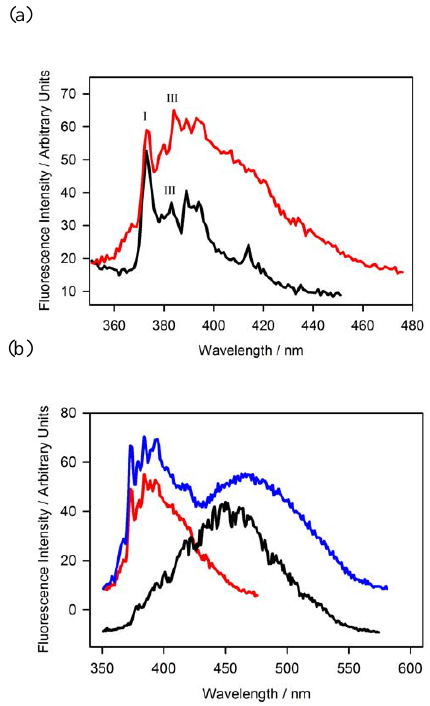
Fig. 1. Fluorescence emission spectra of pyrene measured at the surface of (a) 2.6 × 10 − 7 M solution of pyrene in deionized wa- ter (black) excited at 337nm and 10 − 5 M pyrene in octanol (red) spread on silicone grease and excited at 337nm; (b) 10 − 5 M (red) and 10 − 2 M (blue) pyrene in octanol spread on silicone grease and excited at 337nm, and 2.5µg cm − 2 surface coverage solid pyrene film (black) prepared via evaporation from methanol solution and excited at